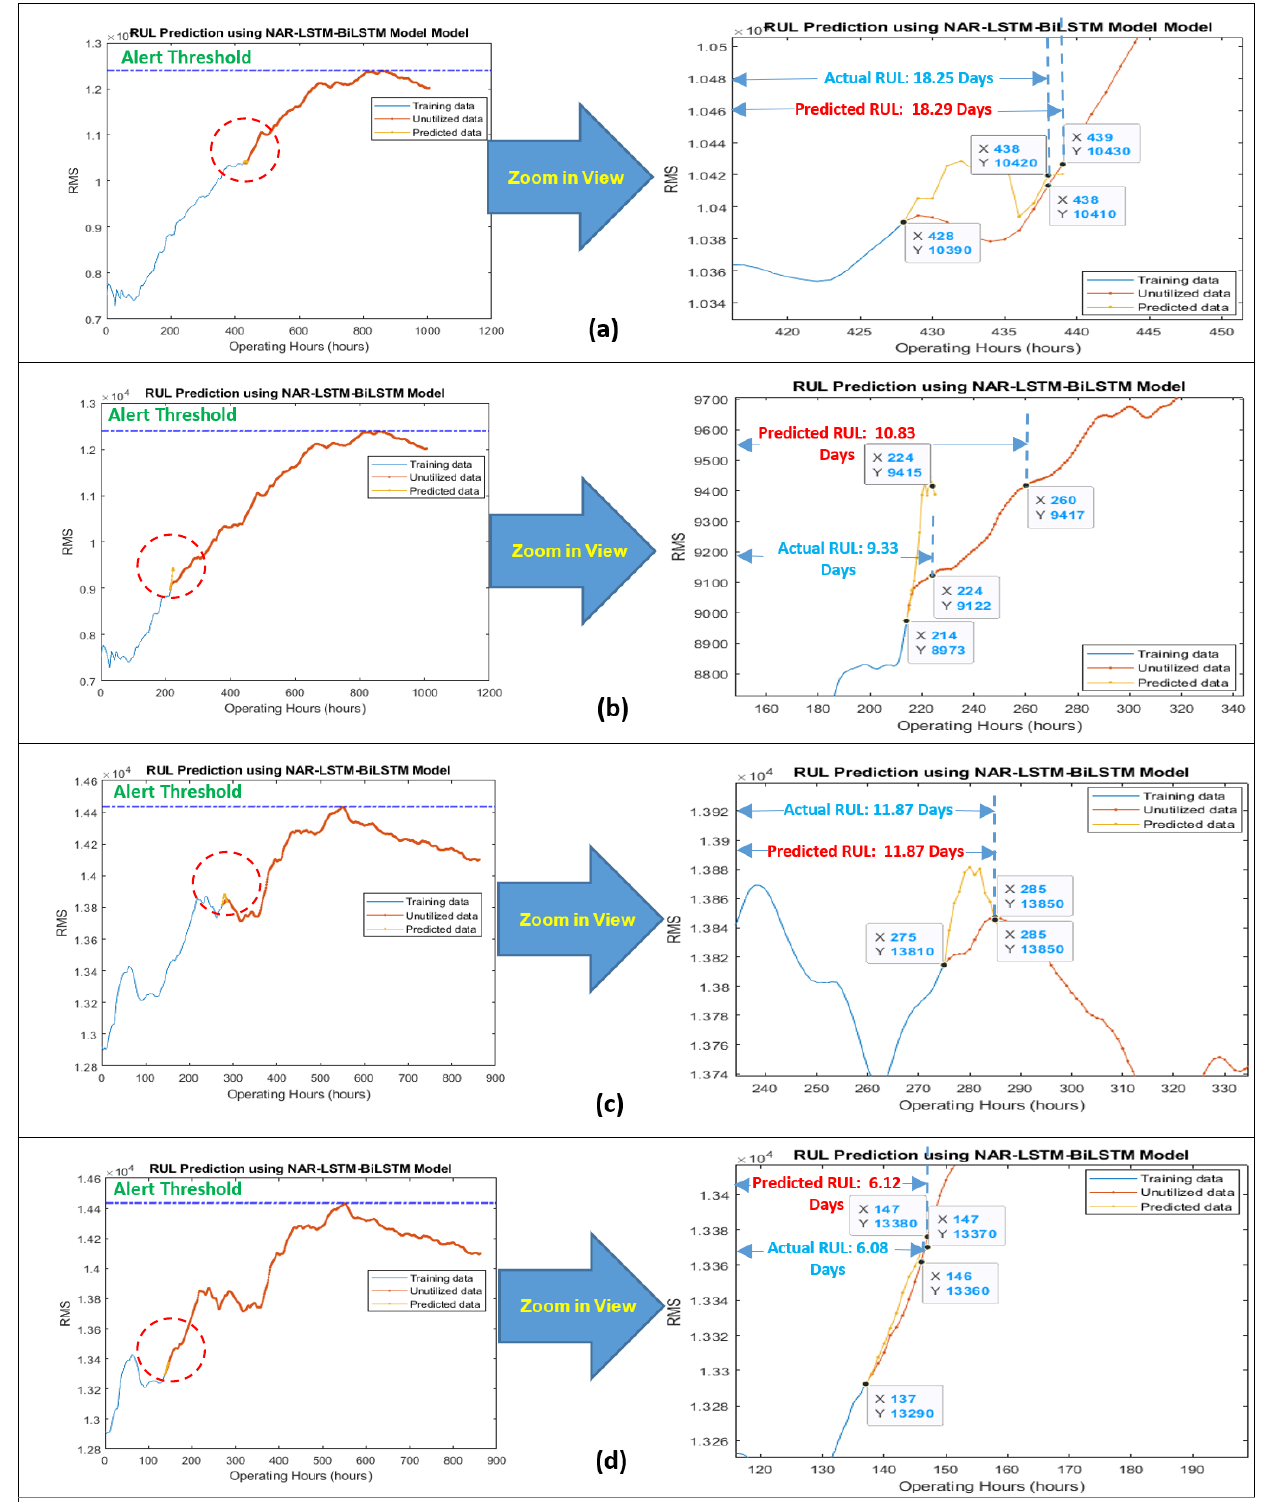
Figure 7. Prediction of short-term RUL for the next 10 h of the slurry pump using data sets 2014 for ( a ) 50% and ( b ) 25% data of degradation trends for training purpose, and dataset 2017 for ( c ) 50% and ( d ) 25% data of degradation trends for training purpose.